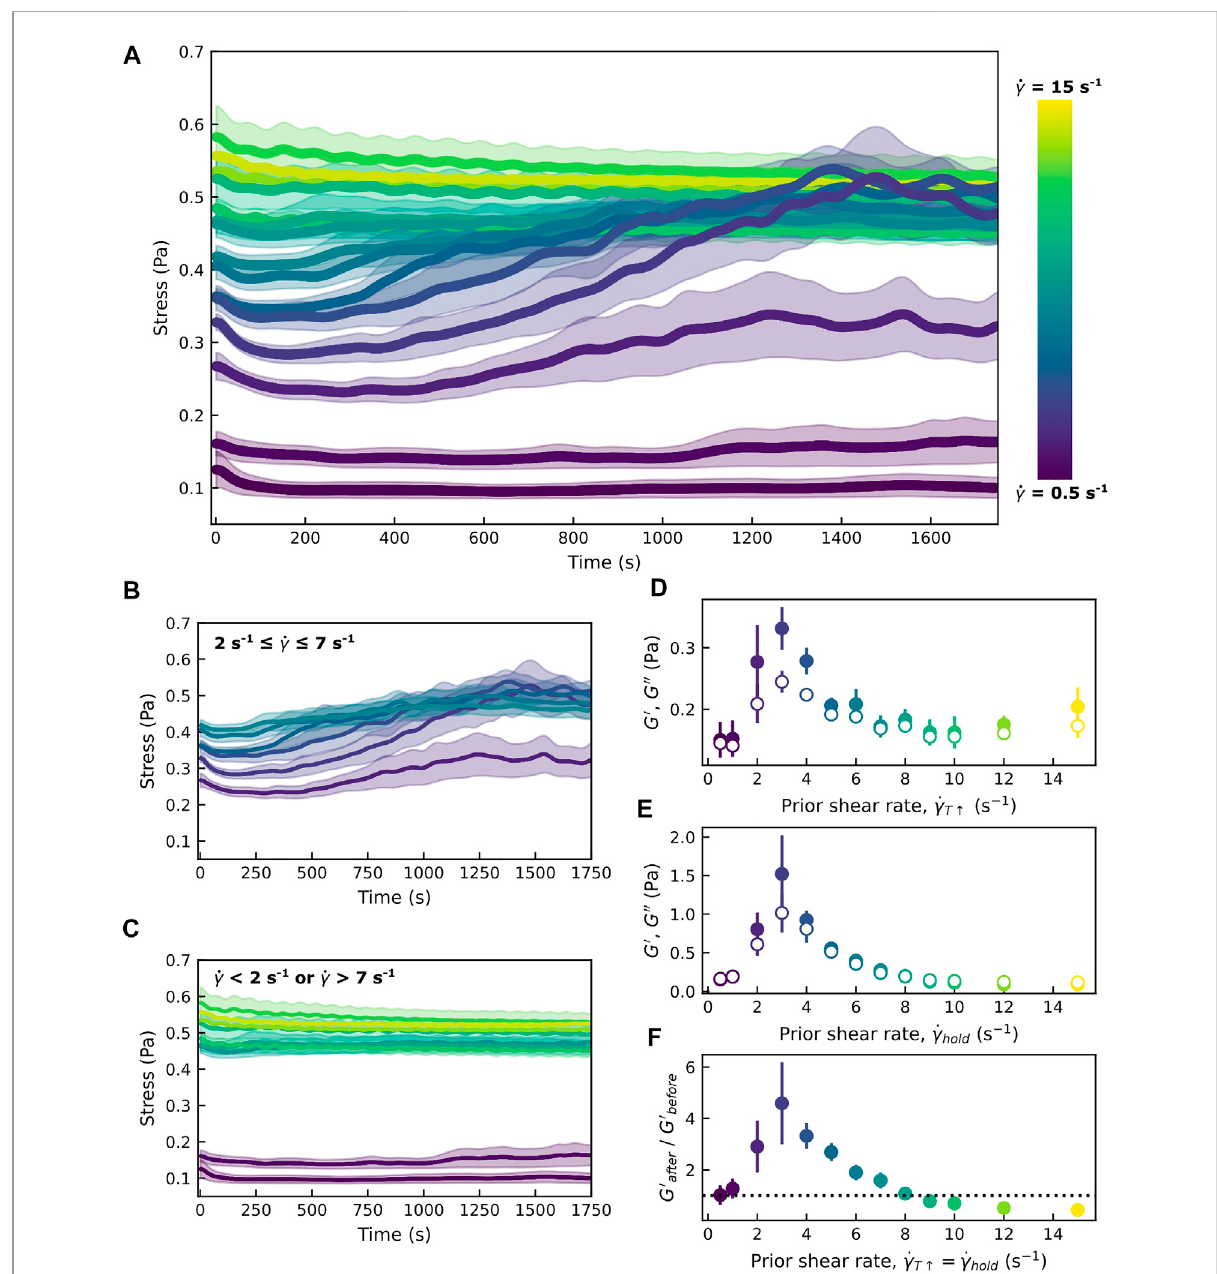
FIGURE 4 Shear-induced fl oc formation coincides with increases in the measured stress. (A) The colloid-polymer sample in a parallel-plate geometry is fi rst heated to 34 ° C as described while subjected to shear at a rate _ γ T ↑ . Following this temperature ramp, the sample is subjected to the same shear rate _ γ hold (cid:1) _ γ T ↑ while being held at 34 ° C. We measure the stress as a function of time during this 30-min period of constant shear rate and constant temperature. Depending on the shear rate used, the stress remains relatively fl at for the 30 min or shows an uptick with increased fl uctuations. This increase in the stress coincides with fl oc formation. We observe this indication of fl oc formation for shear rates of 2 – 7 s − 1 . The stress vs. time is shownforshearratesfrom0.5to15 s − 1 withthesymbolsindicatingthemeanovertypicallysixruns.Theshadedareasrepresentthemean±standard erroracrossthedifferentruns. (B) Same as (A) ,butonlythedata forshearratesof2,3,4,5,6,and7 s − 1 areshown.Thesearetheshearratesforwhich there is a noticeable increase in the stress with time and where vorticity-aligned logs form. (C) As with (B) , we show the same data in (A) but for only shear rates of 0.5, 1, 8, 9, 10, 11, 12, 13, 14, and 15 s − 1 . (D) Oscillatory measurements are performed after the temperature ramp to 34 ° C. During this temperature ramp, the sample was sheared at _ γ T ↑ . Plotted are the storage ( G ′ , solid symbols) and loss ( G ″ , open symbols) moduli for a frequency of ω (cid:1) 1rad/s and amplitude γ (cid:1) 3% as a function of the preceding shear rate _ γ 0 T ↑ . (E) Oscillatory measurements are performed after the sample is held at34 ° C while subjectedtoaconstant shearrate of _ γ hold (setto thesamevalueas thepreceding _ γ T ↑ usedduring thetemperatureramp) for30 min. As in (D) ,the storage and loss moduli are plotted as afunction of _ γ hold . Outside of therange 2 – 7 s − 1 , we observe more liquid-like responses ( G ′ ≲ G ″ ). (F) ( Continued